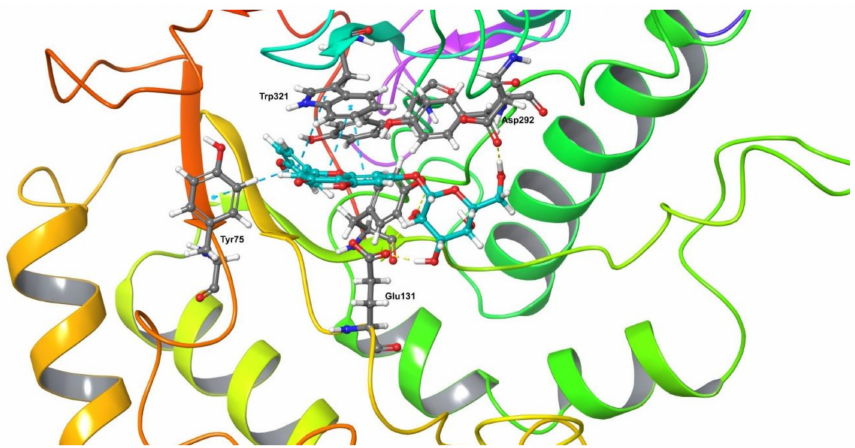
Figure 6. Best pose of the interaction of compound 9 (colored in light blue) with hyaluronidase. The pi-stacking interactions between the flavonoid moiety and the amino acid residues Tyr75 and Trp321 are shown with light blue dashed lines. The hydrogen bonds between the sugar moiety and the amino acid residues Asp292 and Glu131 are shown with yellow dashed